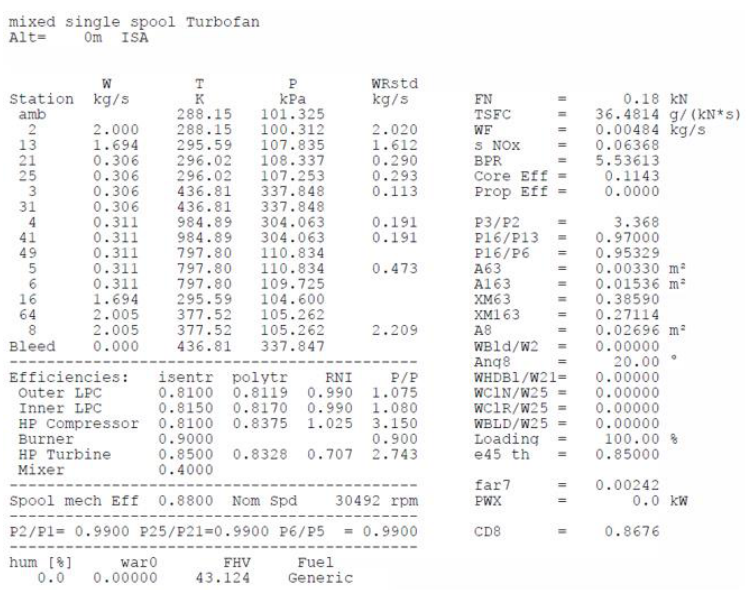
Figure A3. GasTurb simulation results for the baseline turbojet, test facility.